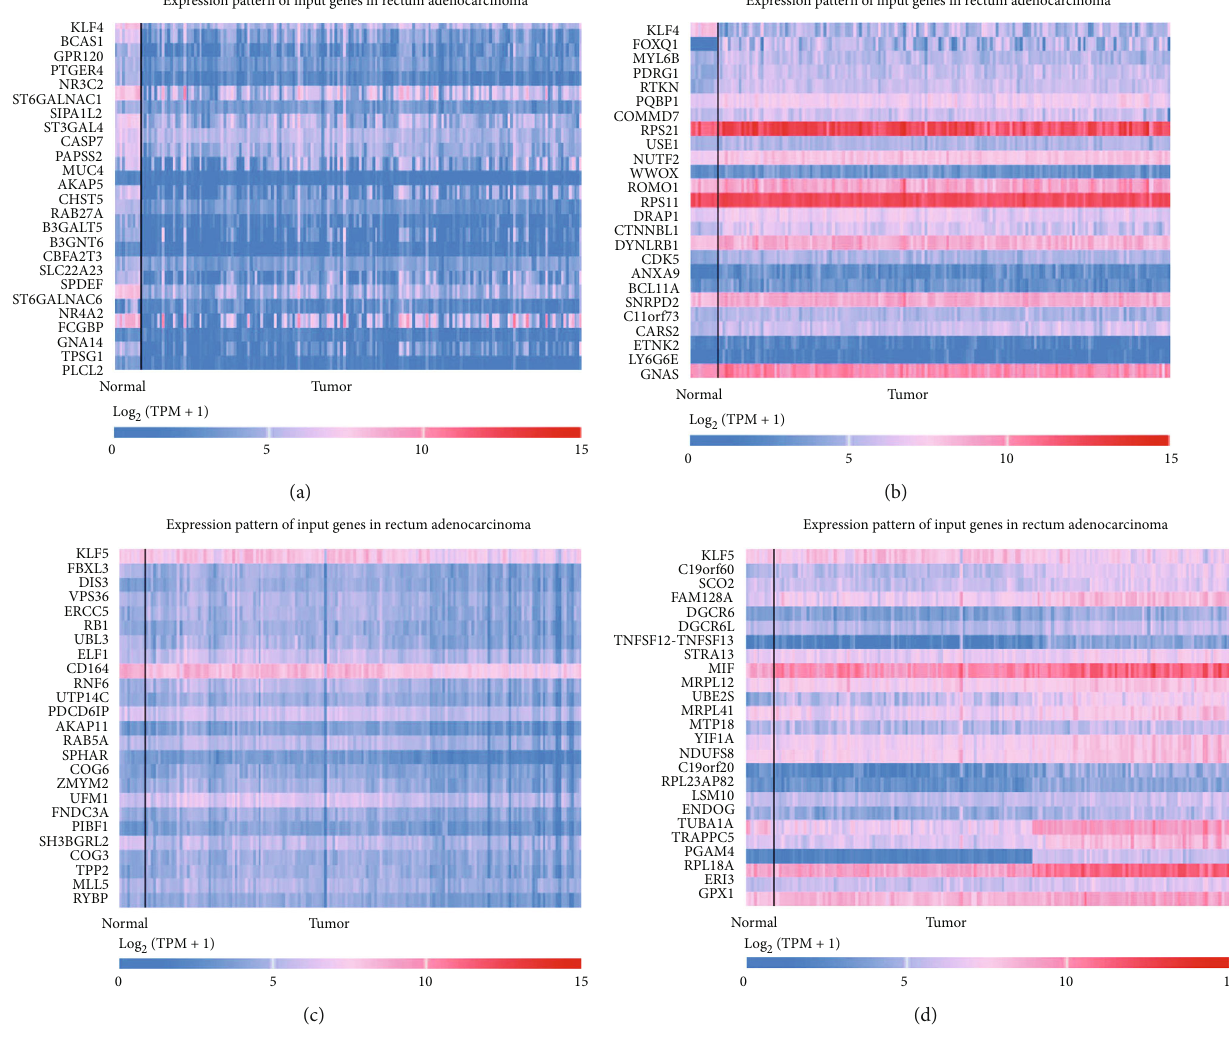
Figure 4: Genes related to KLF4/KLF5 in READ. (a) Genes positively correlated with KLF4 in READ. (b) Genes negatively correlated with KLF4 in READ. (c) Genes positively correlated with KLF5 in READ. (d) Genes negatively correlated with KLF5 in